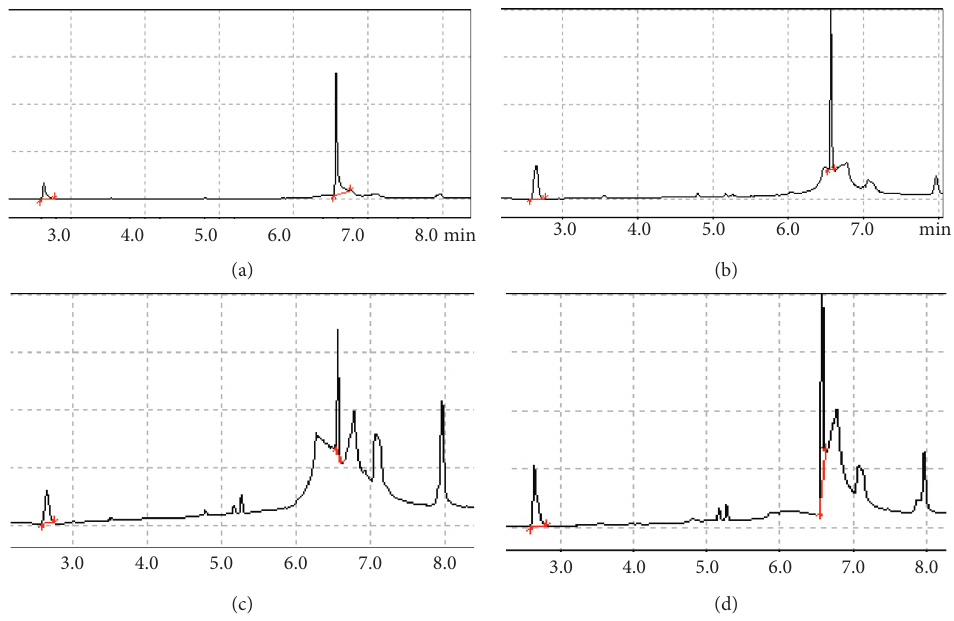
Figure 6: GC spectra of (a) starting materials (6.7min) with internal standard (2.7min); (b) with Ni-VPO; (c) Ni-ZnO; and (d) with Ni-TiO after 90min reaction.